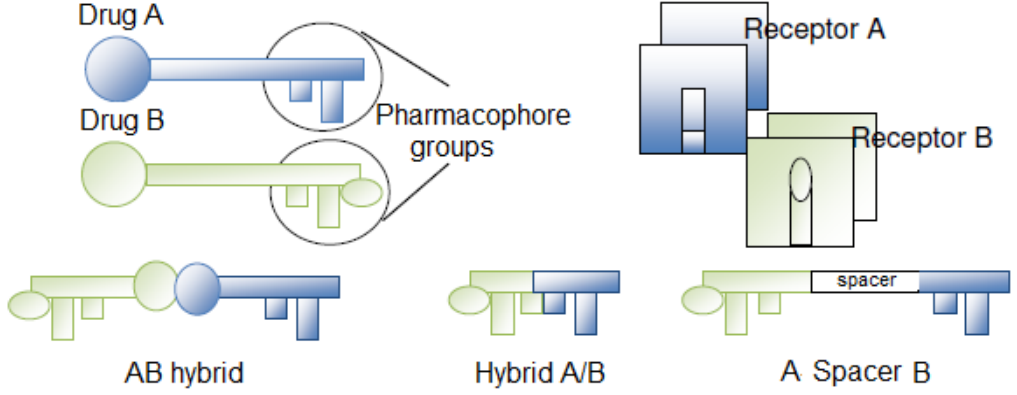
Figure 1. Hybridization approach. The A/B hybrid is obtained by linking the two drugs with or without a spacer subunit